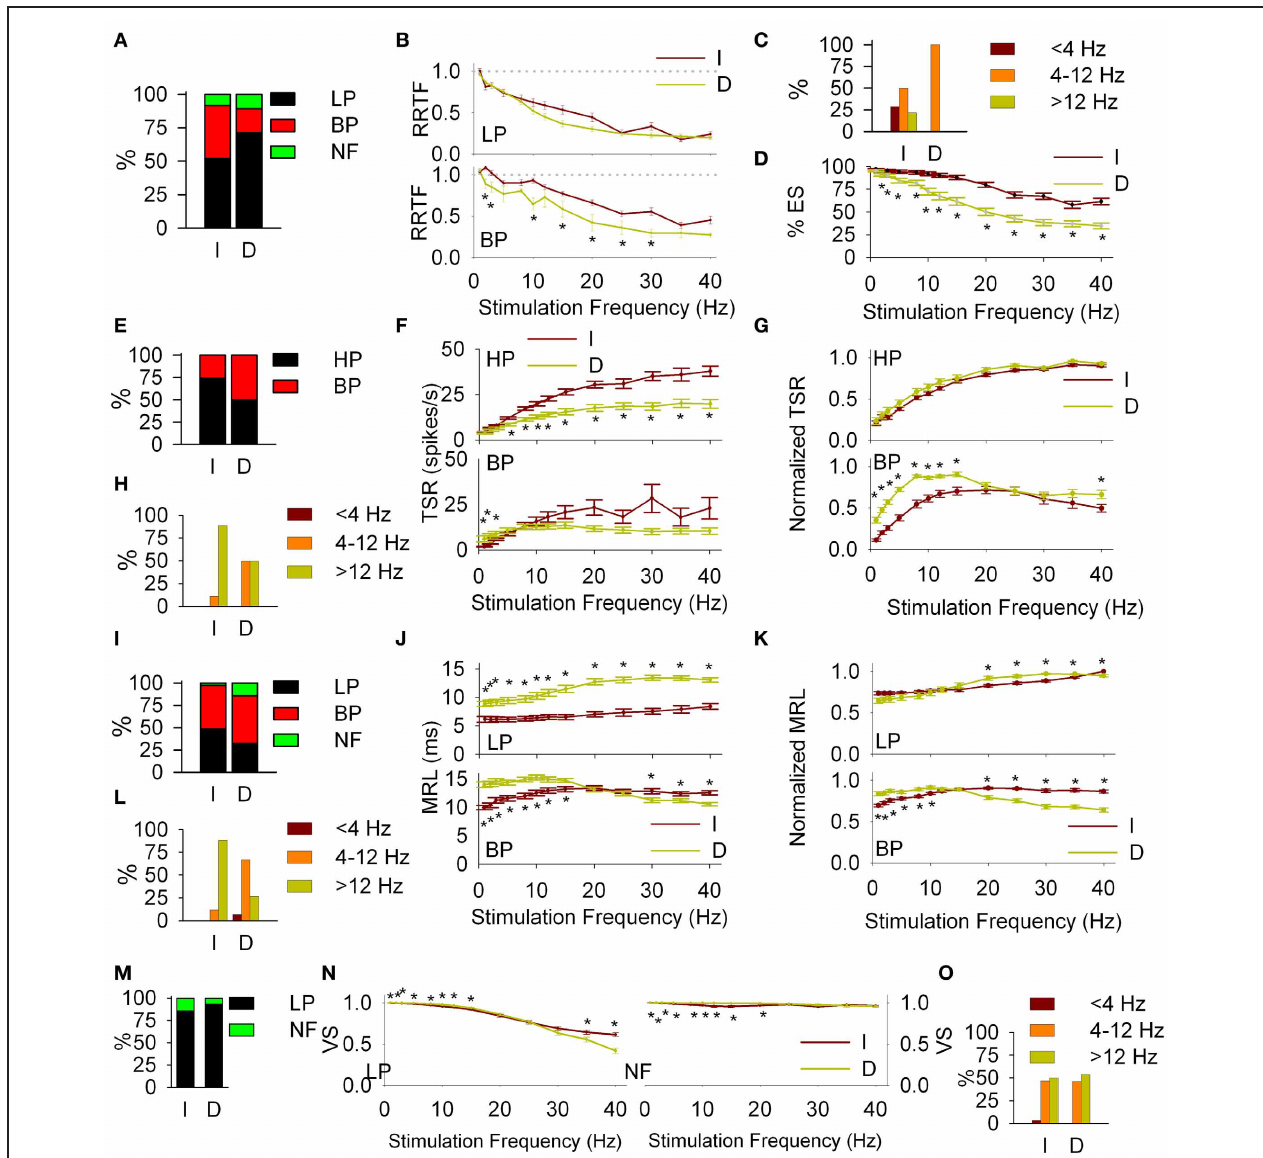
FIGURE 6 | Cortical modulation of PrV filtering properties. Comparisons of intact (I) and decorticated (D) animals. Early response (RRTF): percentages of low-pass (LP) and band-pass (BP) responses (A) ; mean values of LP and BP recordings (B) ; distribution of BP frequencies in the three frequency ranges (C) and effectiveness of the stimulation (D) . Main differences are observed in the distribution of BP frequencies, BP mean values and effectiveness. Global response (TSR): percentages of HP and BP responses (E) ; mean values of high-pass (HP) and BP recordings, crude (F) and normalized (G) ; distribution of BP frequencies in the three frequency ranges (H) . Main differences are observed in BP mean values